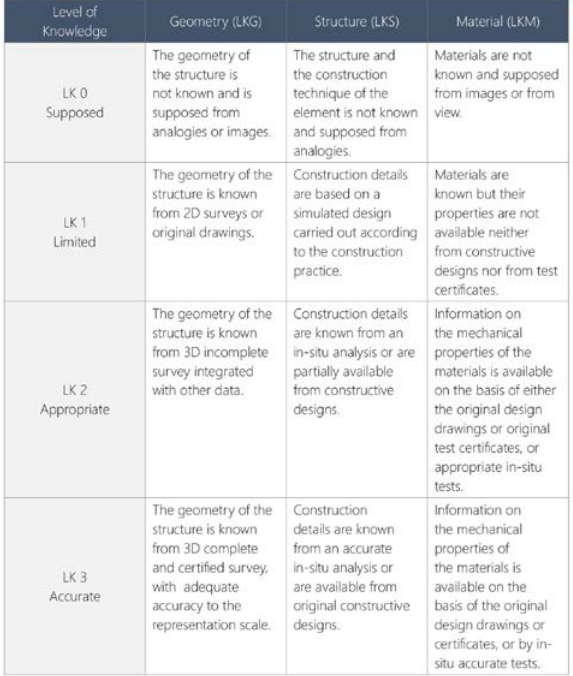
Figure 9_ Implemented Level Of Knowledge (LK)